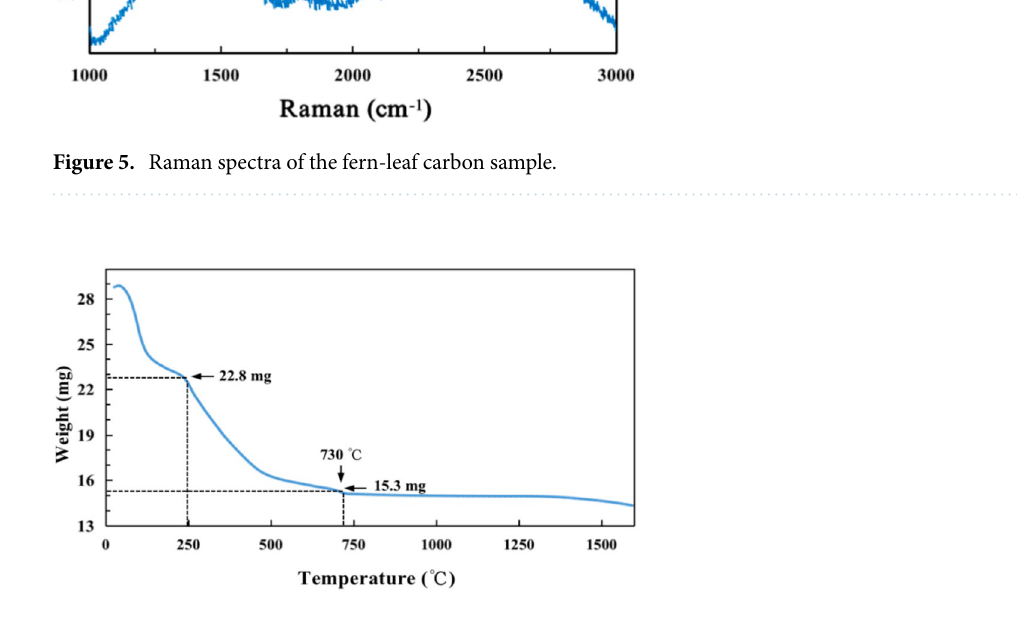
Figure 6. TG curve of the carbon ferrite